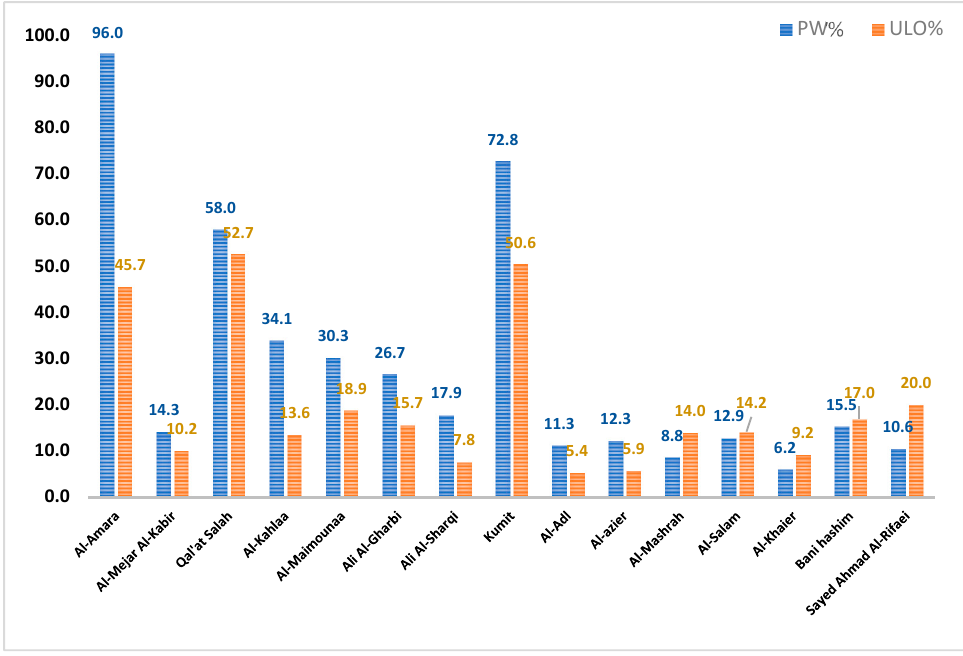
Figure 1. Accumulation of PW vs. ULO in tons throughout the Iraq’s governorates.